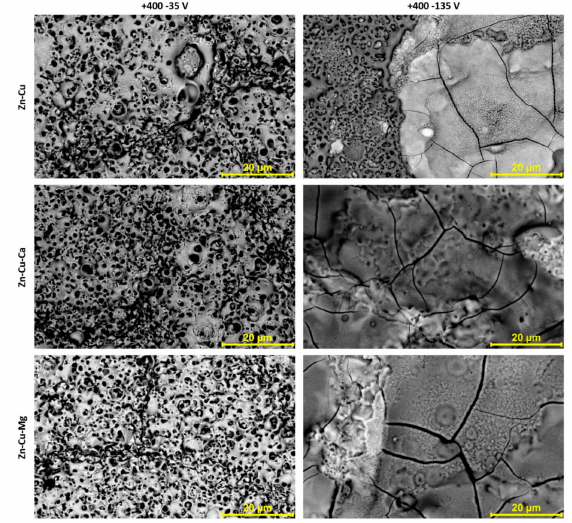
Figure 3. The optical images of AC-PEO coatings fabricated at negative pulses − 35 V and − 135 V with the same positive voltage of + 400 V.